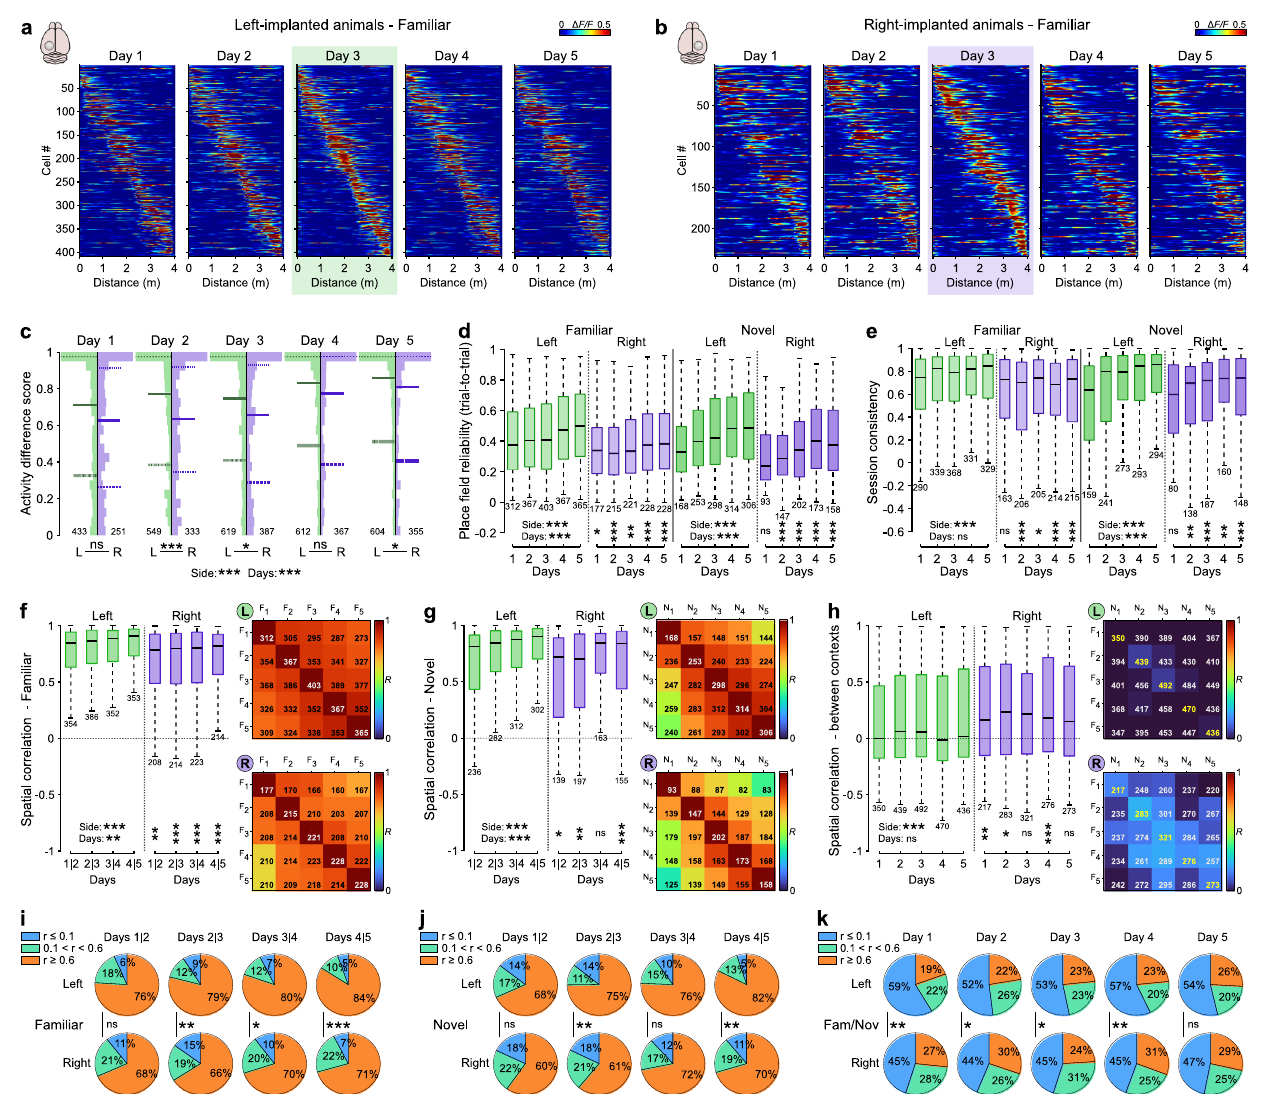
Fig. 3 | Place granule cells of left and right DG show different levels of dis- crimination between familiar and novel environments. a , b Activity maps of place GCs imaged over 5 consecutive days in left ( a ) and right ( b ) DG in the familiarenvironment.Sortingaccordingtothecellsactivityonday3(21micein total; 11 left-implanted and 10 right-implanted mice). c Activity-rate difference scores (|(activity (Fam) – activity (Nov) )|/(activity (Fam) +activity (Nov) ), see also “ Methods ” ) between familiar and novel environments of place GCs. d Mean place fi eld reliability (pairwise cross-correlations between all runs on the same track) of place GCs. e Mean session consistency (activity correlation between the fi rst fi ve and last fi ve runs in a given environment) of place GCs. f Spatial correlation from one day to the next, familiar environment. Left panel, mean activity correlation between 2 consecutive days for place GCs, familiar envir- onment. Right top panel, median activity map correlations (color-coded; Pearson ’ s R) over 5 consecutive days on the familiar track (F1 – F5). Each row